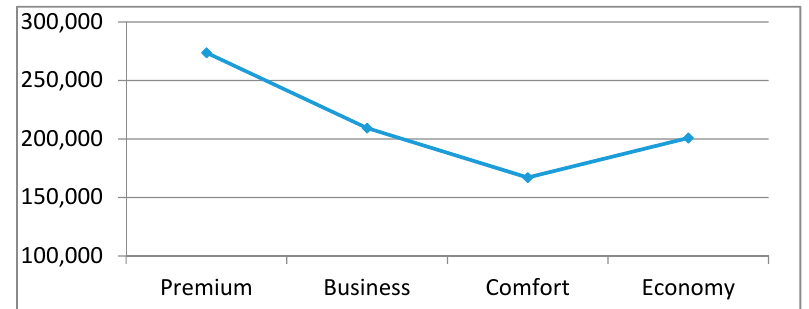
Figure 6. Total heat use (MJ) vs. building comfort level.